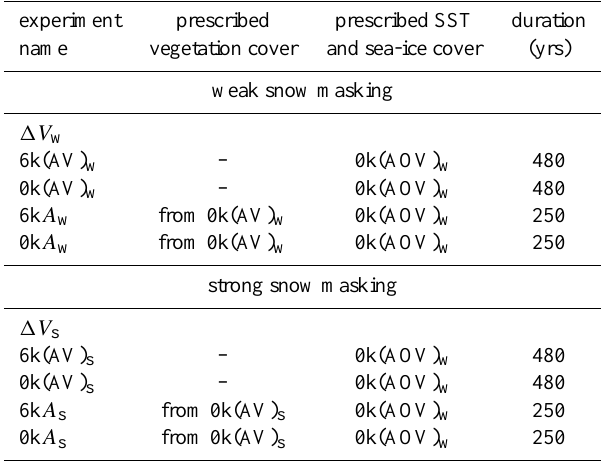
Table 1. List of experiment setup and